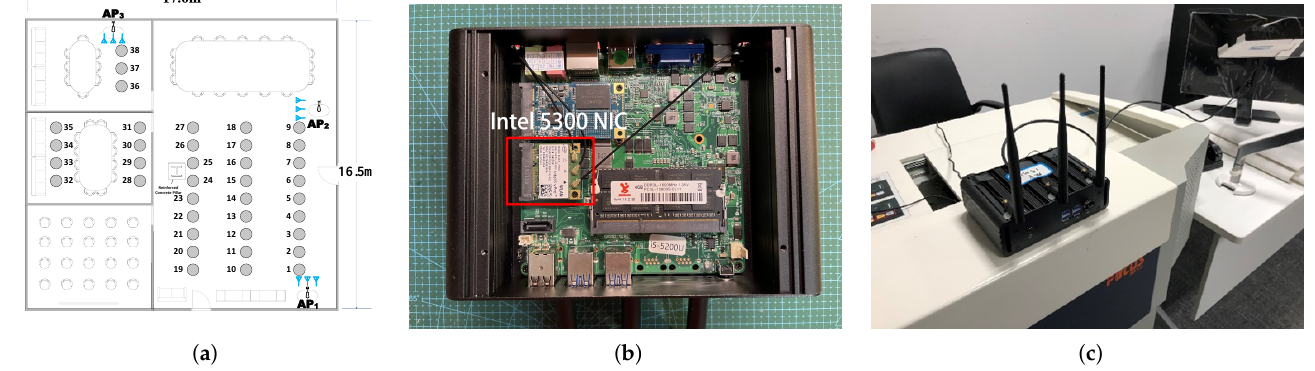
Figure 5. Experimental configurations. ( a ) There are 38 TPs and the blue symbols show the orientation of the antenna array; ( b ) ICC with Intel 5300 NIC; ( c ) practical deployment of APs.